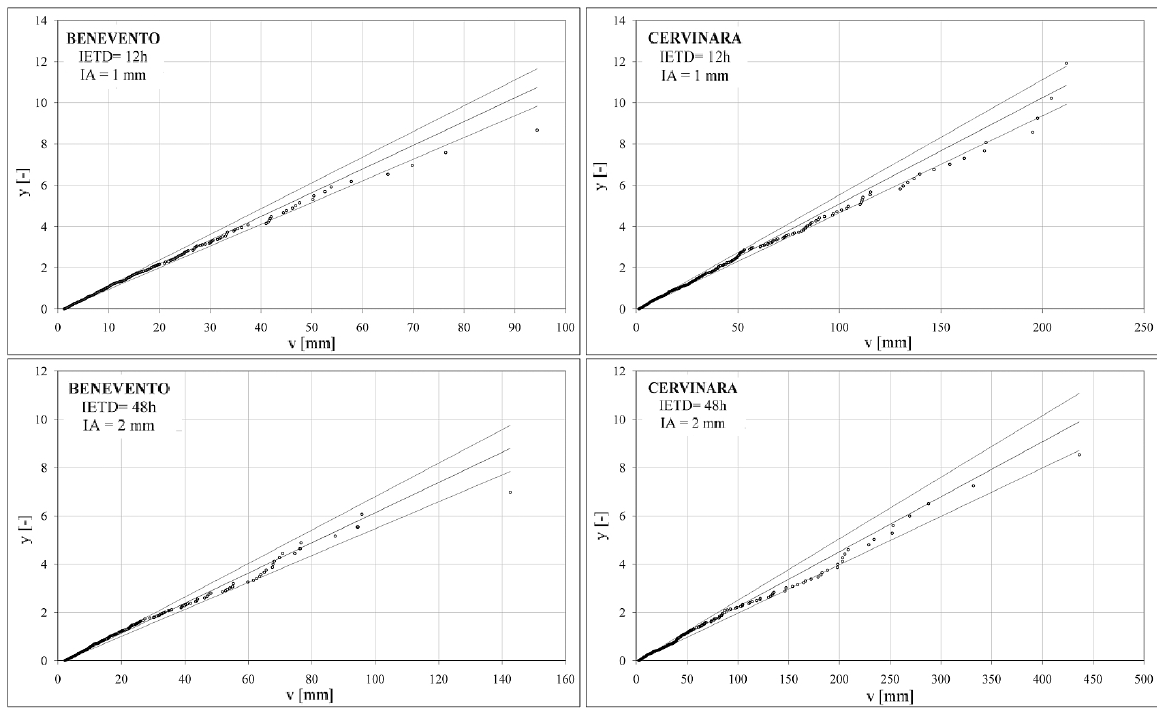
Figure 6. Adaptation of the samples derived from the time series of precipitation of Benevento and Cervinara values for IETD = 12 and 48 h, and Ia = 1 and 2 mm.